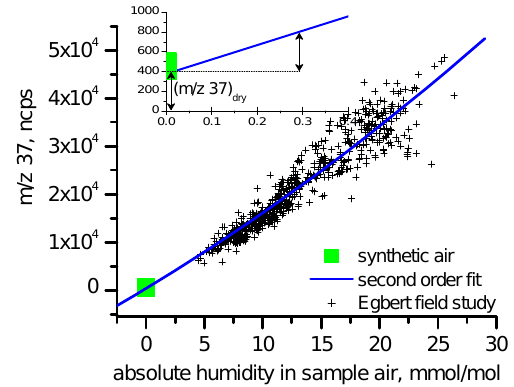
Fig. 4. Comparison of HCHO mixing ratio measurements by the PTR-MS and Hantzsch monitor using a permeation HCHO source and synthetic air as the carrier gas. The Hantzsch monitor HCHO mixing ratios are calculated using a liquid calibration standard (squares). PTR-MS mixing ratios are calculated from m/z 31 sig- nal using Eq. (4)